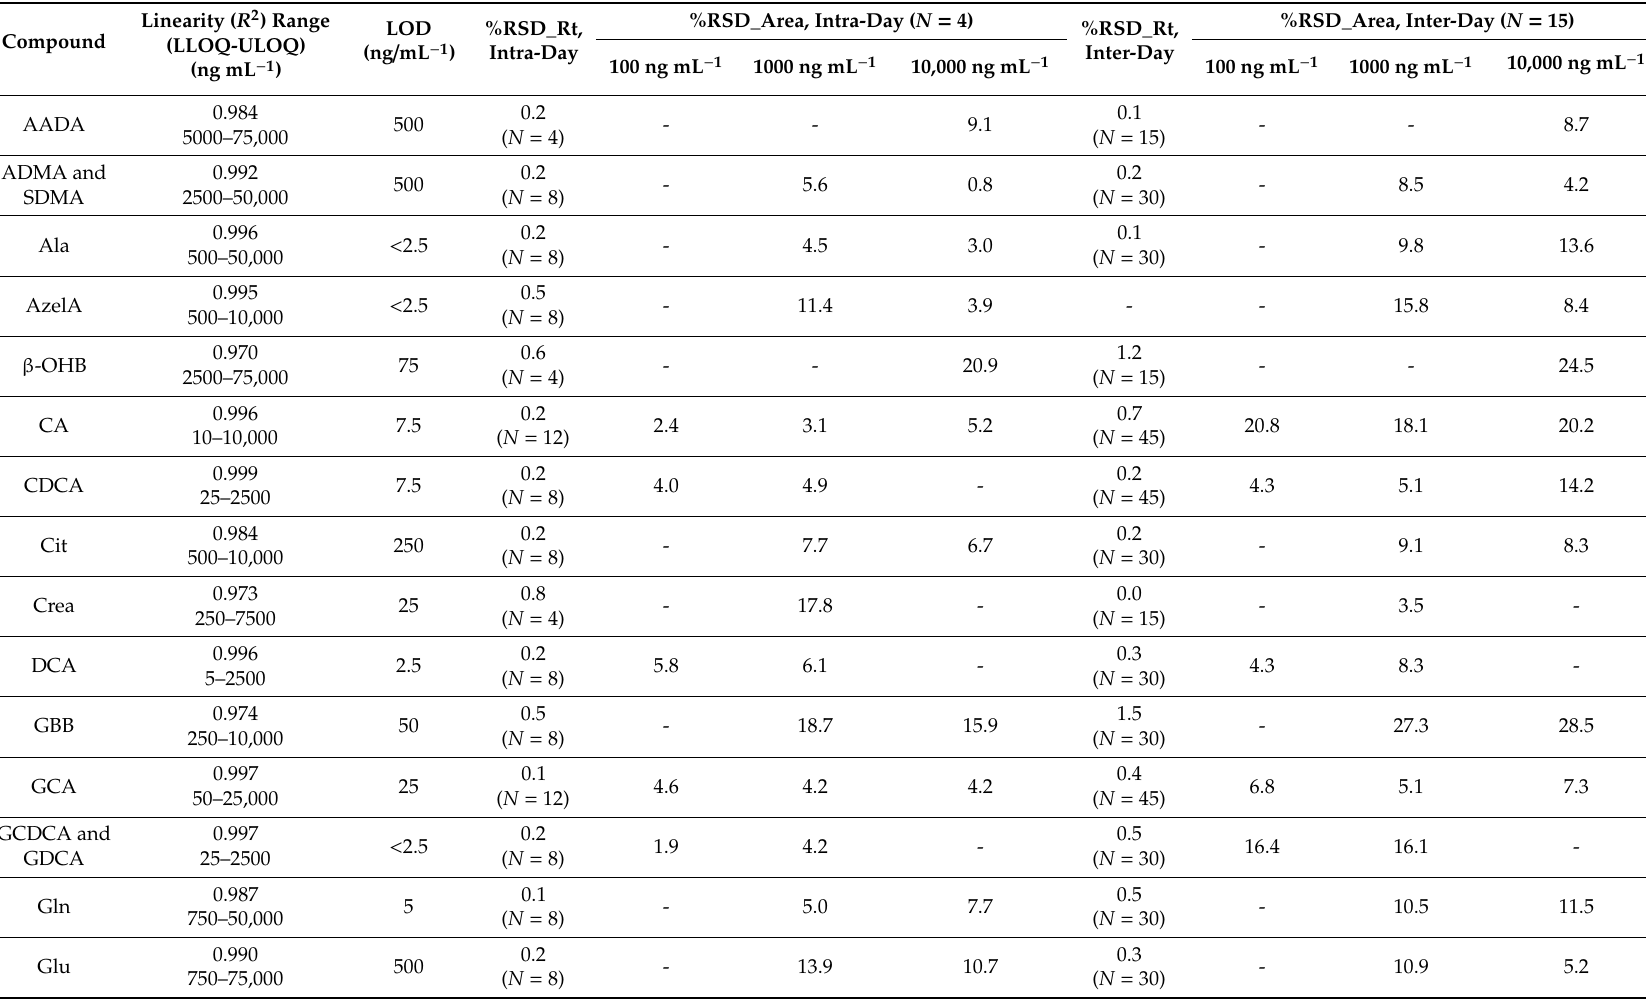
Table 3. Linearity ( R 2 ) with lower and upper limits of detection (LLOD and ULLOQ), linear range, repeatability of retention times (Rt) and intra- and inter-day repeatability of concentrations at di ff erent